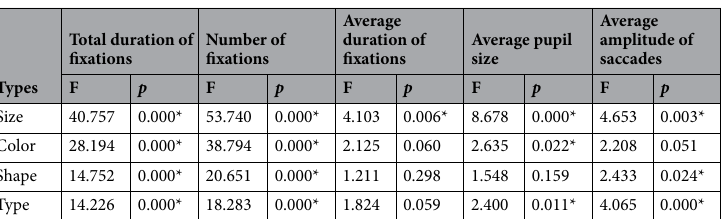
Table 7. ANOVA results of eye movement indexes of different types of fruits. *Indicating that there is a difference in the index of this feature.